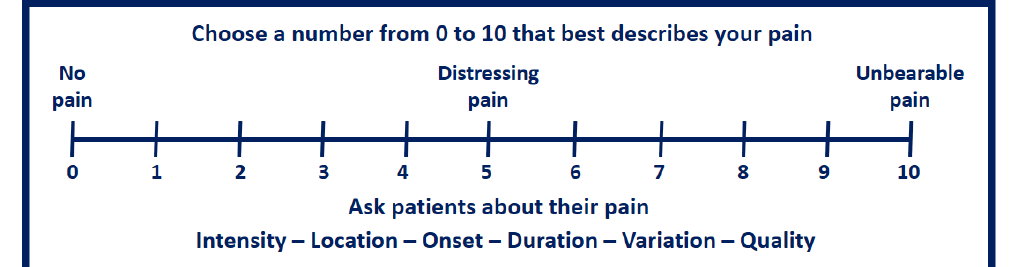
Figure 1. Visual analogue scale (VAS) for assessing pain (adapted from